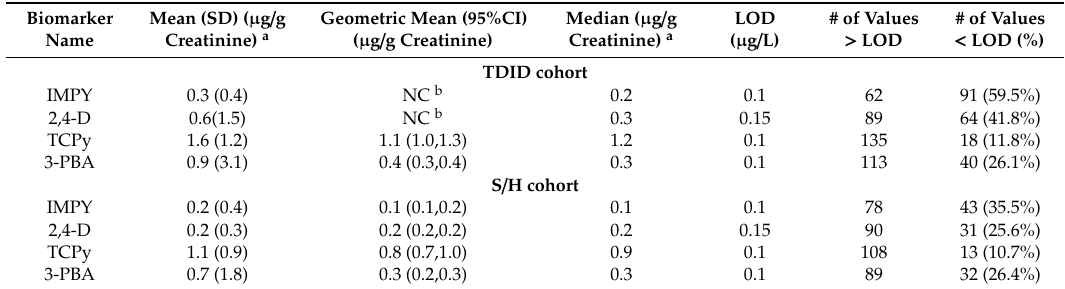
Figure 2. Comparison of four metabolites, 2,4-D, 3-PBA, IMPy, and TCPy, by cohort and by baseline sociodemographic characteristics of TDID and S / H cohort participants. ( A ) Comparing concentrations of 2,4-D, 3-PBA, IMPy and TCPy in the S / H and TDID cohorts in terms of employment status. ( B ) Comparing concentrations of 2,4-D, 3-PBA, IMPy and TCPy in the S / H and TDID cohorts in terms of maternal education. ( C ) Comparing concentrations of 2,4-D, 3-PBA, IMPy and TCPy in the S / H and TDID cohorts in terms of household income. ( D ) Comparing concentrations of 2,4-D, 3-PBA, IMPy and TCPy in the S / H and TDID cohorts in terms of marital status. Table 2. Pesticide Exposure descriptive statistics in TDID and S / H